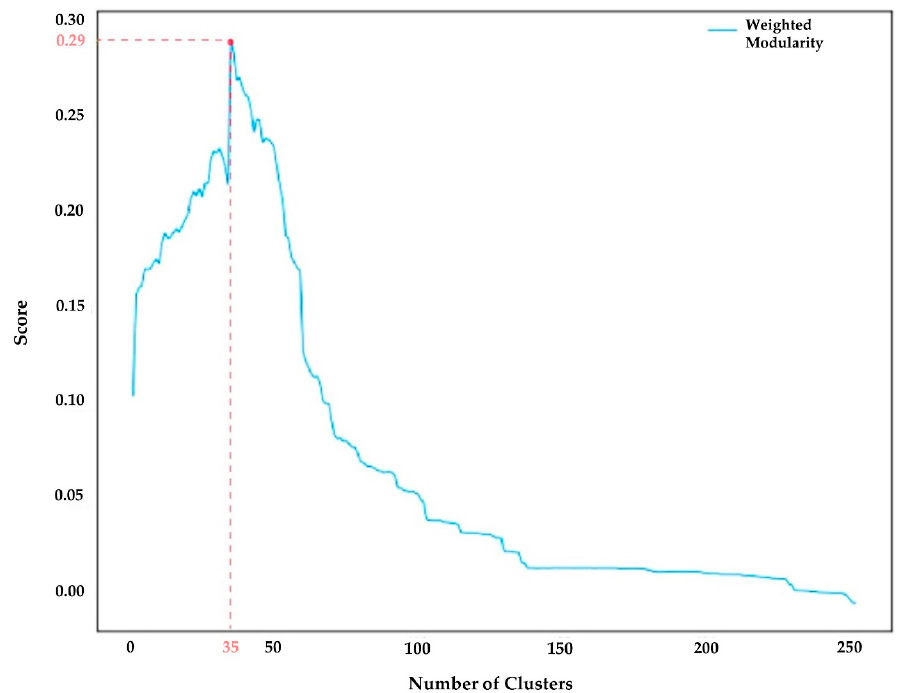
Urban Sci. 2022 , 6 , x FOR PEER REVIEW